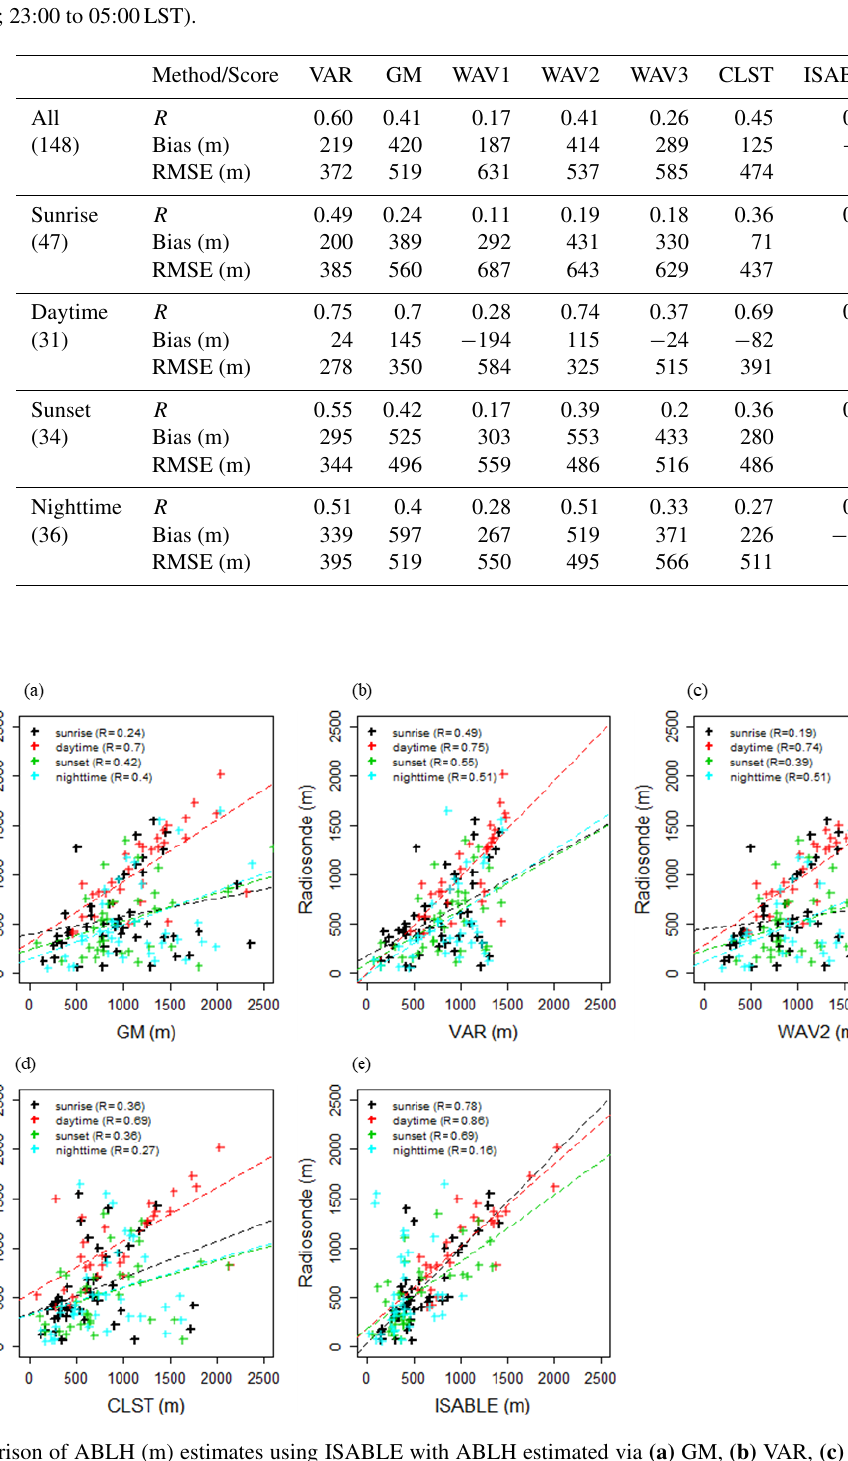
Figure 10. Comparison of ABLH (m) estimates using ISABLE with ABLH estimated via (a) GM, (b) VAR, (c) WAV2, (d) CLST, and (e) ISABLE for sunrise time ( N = 47; 06:00 to 11:00LST), daytime ( N = 31; 12:00 to 17:00LST), sunset time ( N = 34; 18:00 to 22:00LST), and nighttime ( N = 36; 23:00 to 05:00LST). The numbers in parentheses represent the correlation